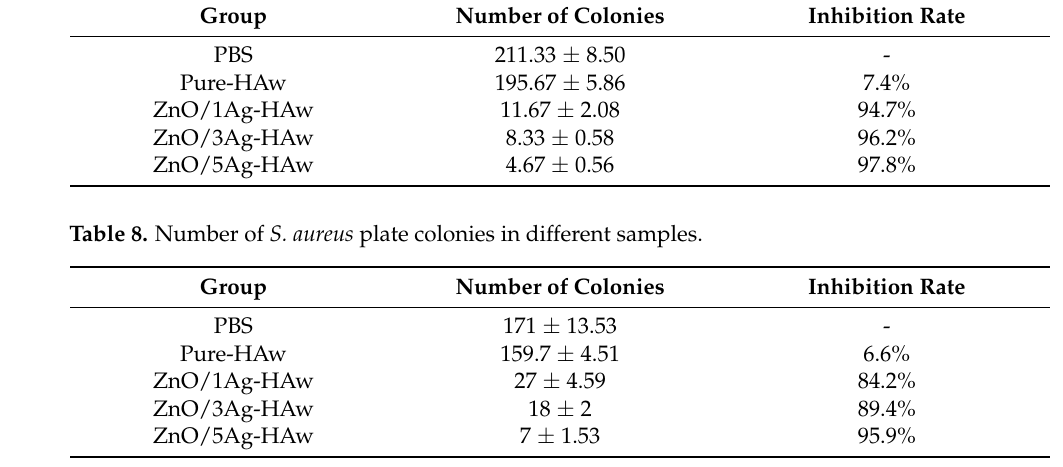
Table 7. Number of E. coli plate colonies in different samples. Group Number of Colonies